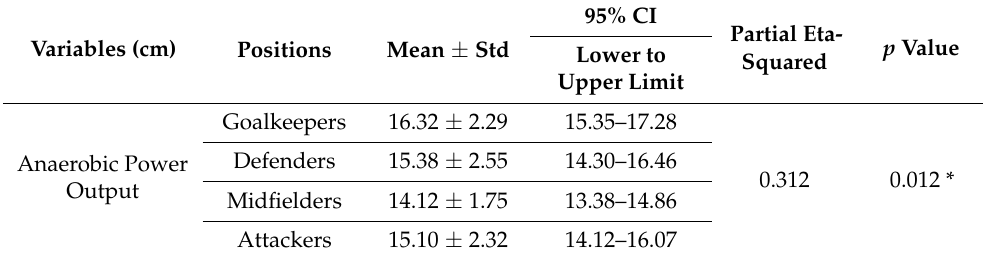
Table 2. Statistical analysis of variance of anaerobic output values of soccer players for their playing position.